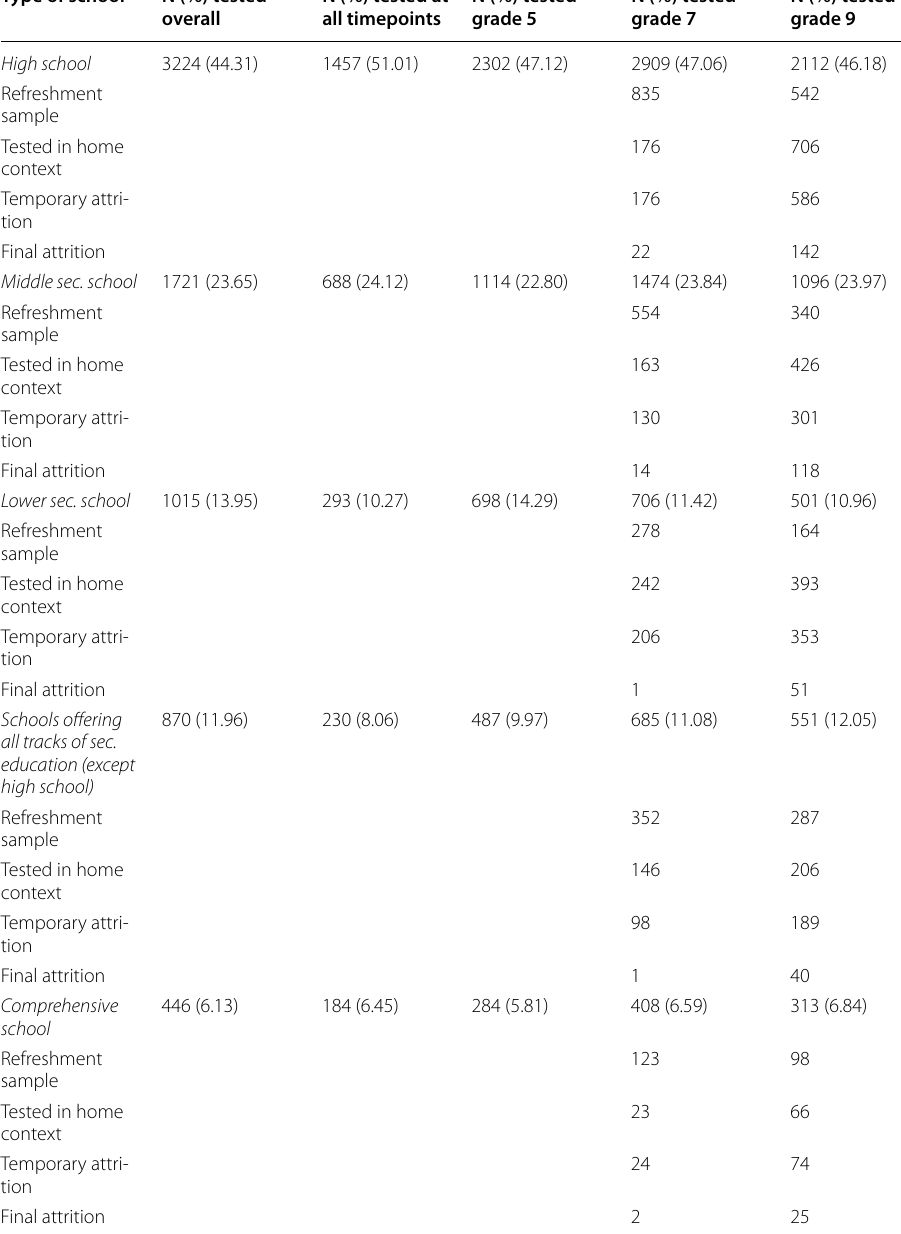
Absolute numbers are presented with percentages in parentheses. The percentages are to be read column